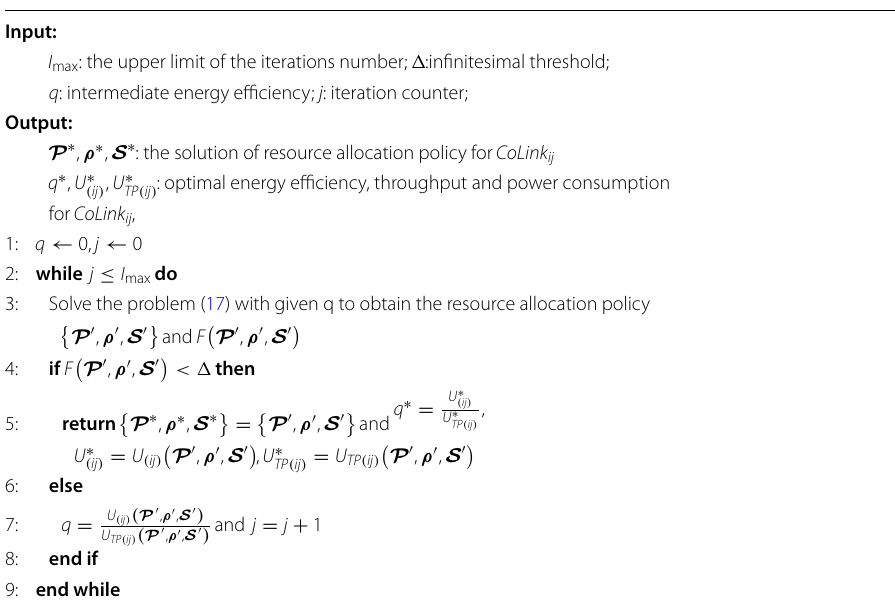
Table 2 Energy efficient subnet resource allocation algorithm EESRA: Energy efficient subnet resource allocation